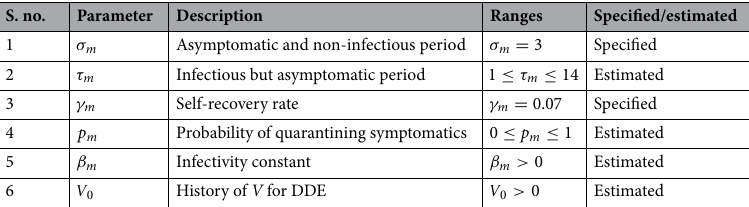
Table 1. Parameters used in the mean- β model.